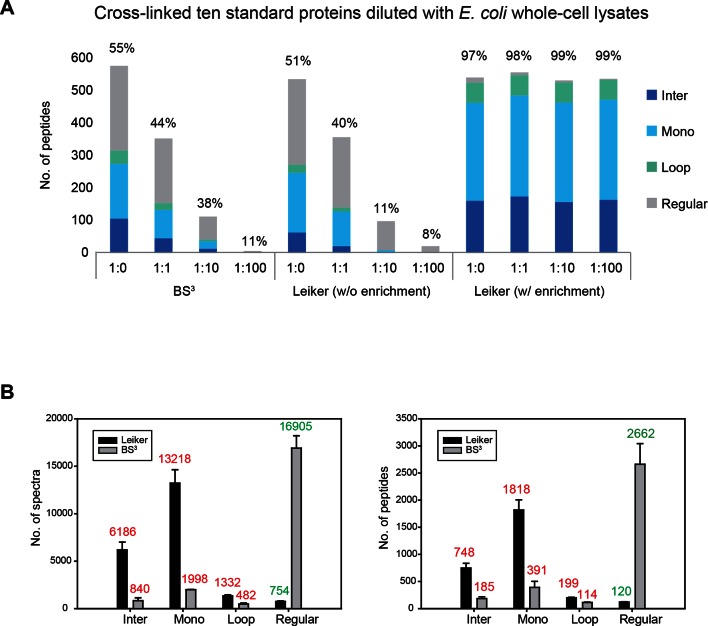
Evaluating the performance of Leiker.(A) Leiker allowed near 100% enrichment of target peptides from a cross-linked ten-protein mixture diluted with increasing amounts of non-cross-linked E. coli lysates. Dark blue, inter-links; light blue, mono-links; green, loop-links; grey, regular peptides not modified by Leiker. (B) Number of cross-link identifications from E. coli lysates treated with Leiker or BS3. Shown in the left and right panels are the identified spectra and peptides, respectively.DOI:
http://dx.doi.org/10.7554/eLife.12509.01110.7554/eLife.12509.012Figure 3—source data 1.Ten standard proteins used to evaluate Leiker, mixed at equal amounts by mass.DOI:
http://dx.doi.org/10.7554/eLife.12509.01210.7554/eLife.12509.013Figure 3—source data 2.Summary of identified spectra from the ten-protein mixture.